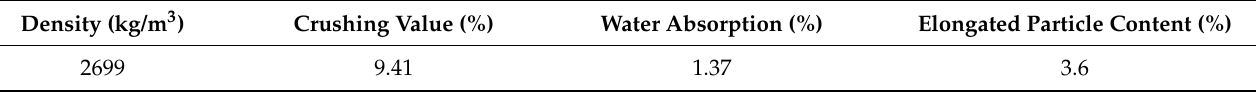
Table 2. Aggregate performance.